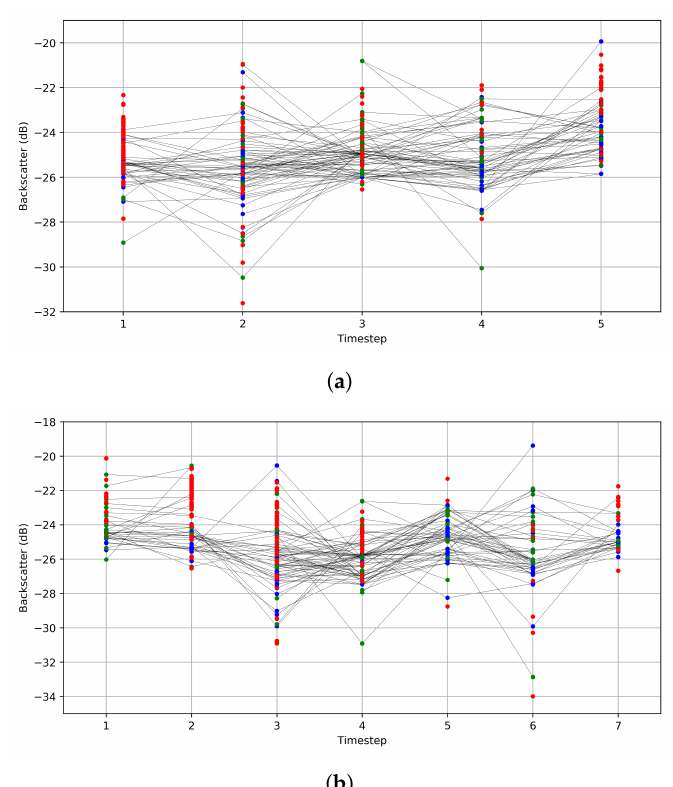
Figure 8. Global temporal profiles for VH polarisation. Unconnected polygons (red nodes), temporary entities (green nodes), and permanent entities (blue nodes). ( a ) Ascending time series VH polarisation. ( b ) Descending time series VH